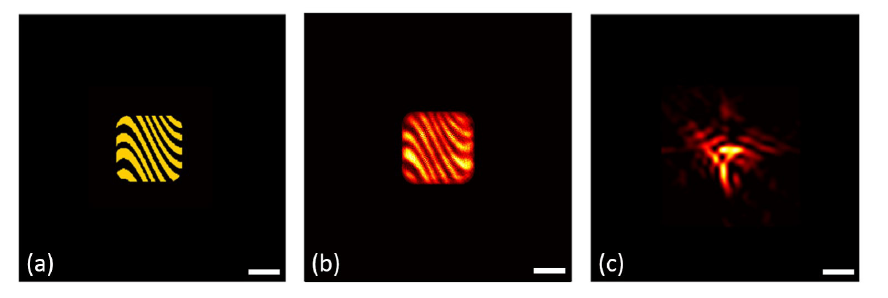
Figure 3. Experimental results with scanning probe aperture. ( a ) The target image and the reconstructed image using ( b ) the proposed method and ( c ) the traditional hybrid input–output (HIO) phase retrieval algorithm. Scale bar: 1